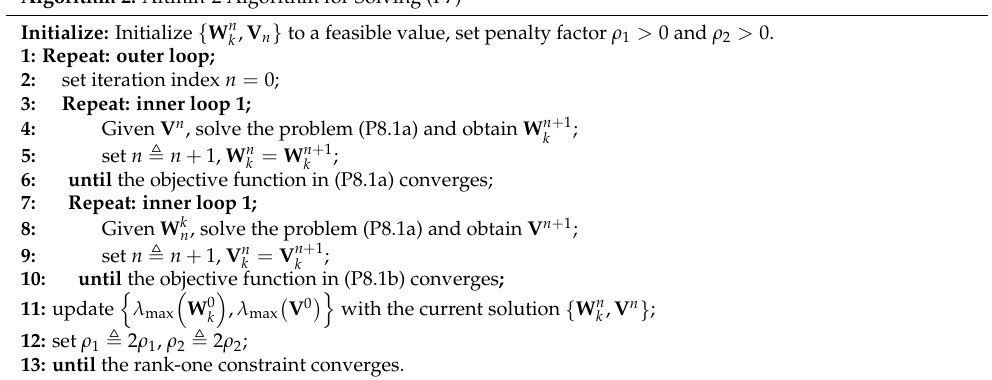
Algorithm 2. Altmin-2 Algorithm for Solving